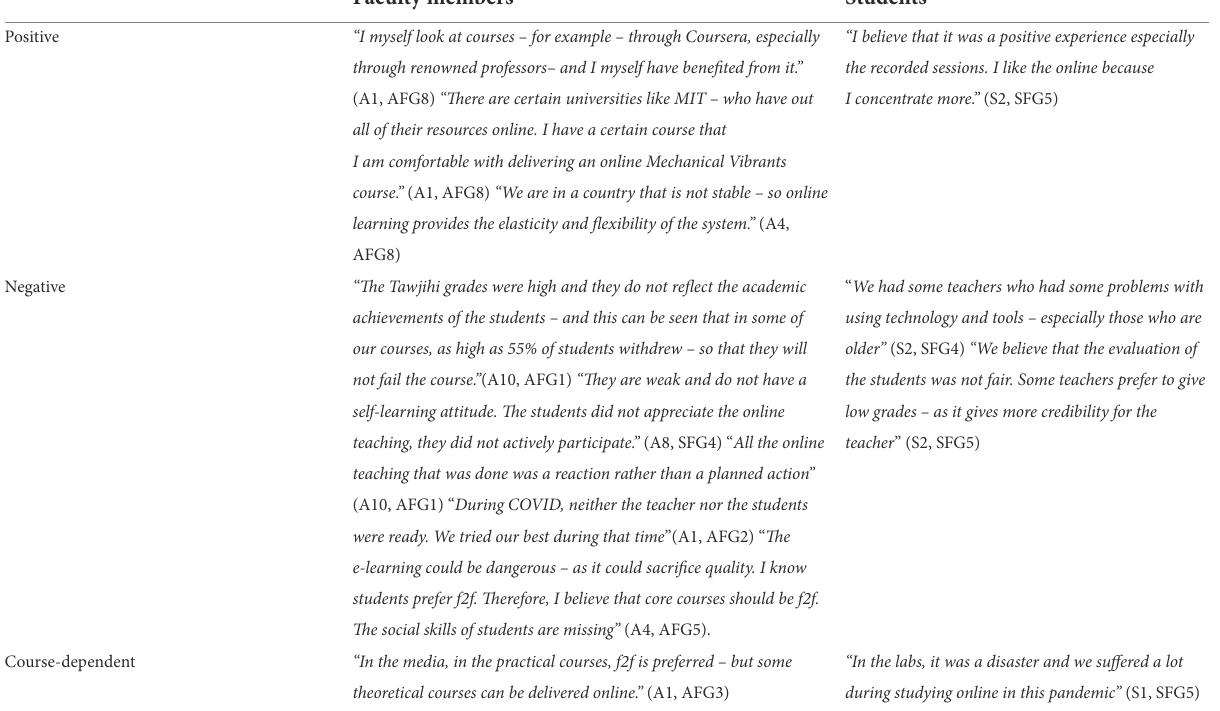
TABLE 6 Attitudes of faculty members and